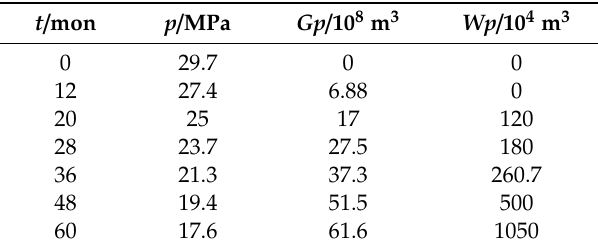
Table 2. Production dynamic data of gas reservoir Z1.